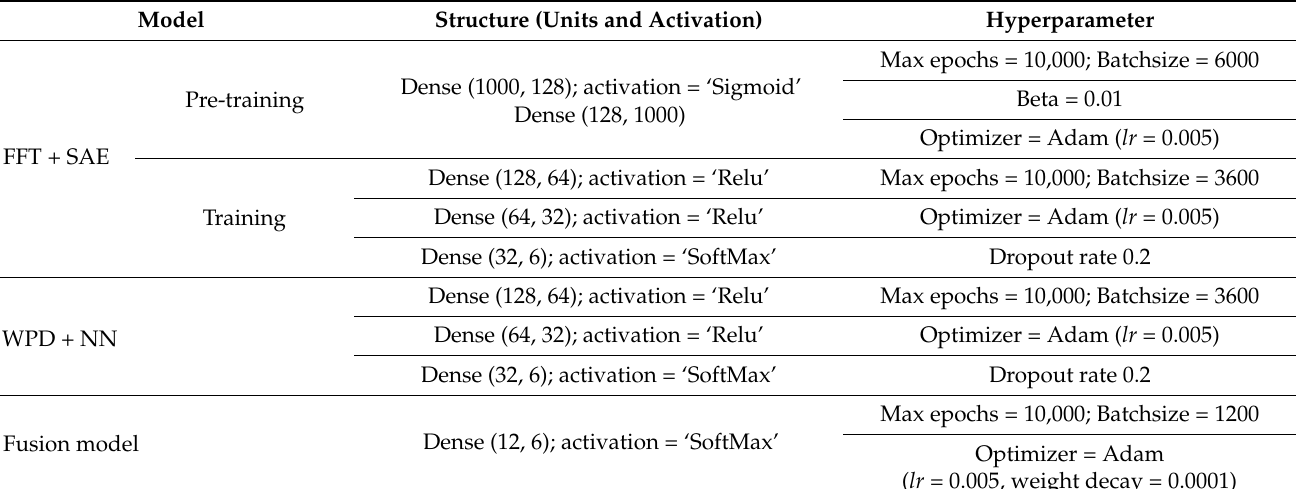
Figure 6. The schematic of the fusion model. Table 1. Structure and hyperparameter settings of the three classifier models.